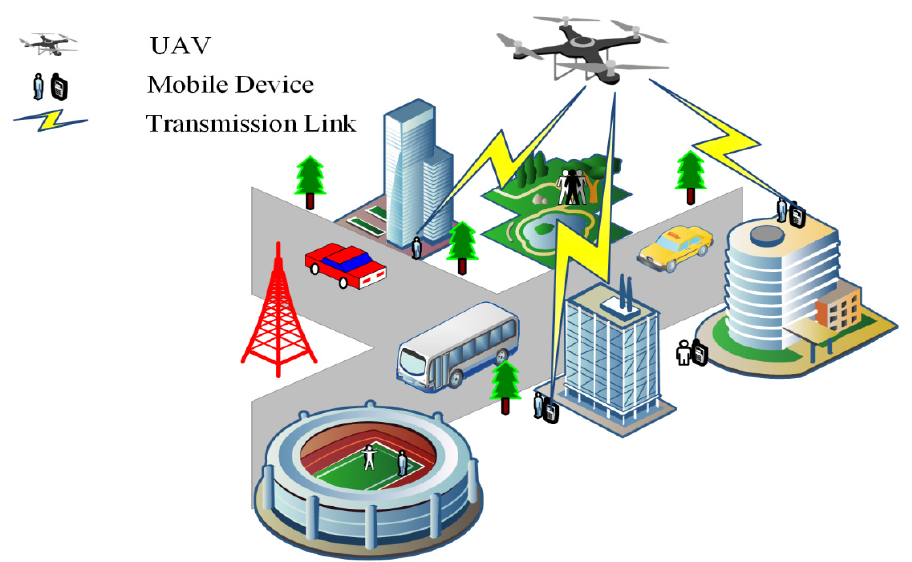
Figure 1. The overview of system